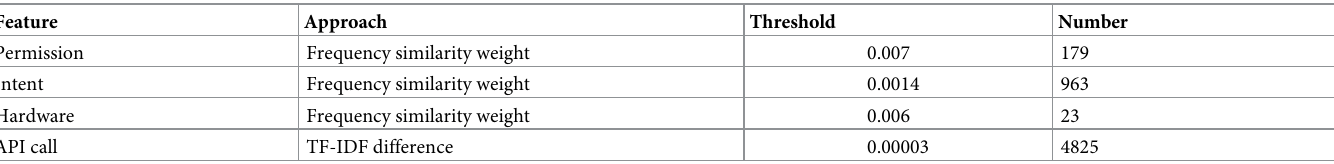
Table 4. The details of the features processed by FSMW.